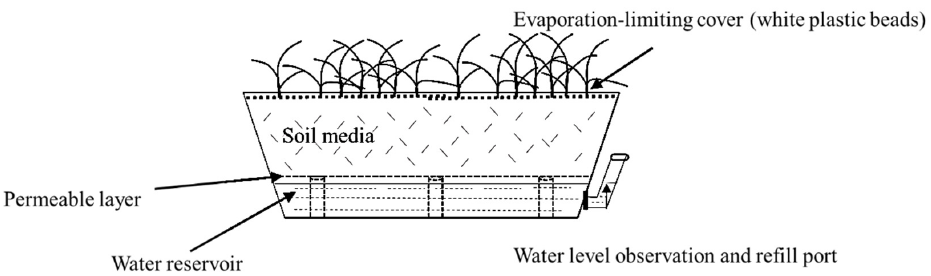
Figure 2. Schematic diagram of the plant growth tubs.